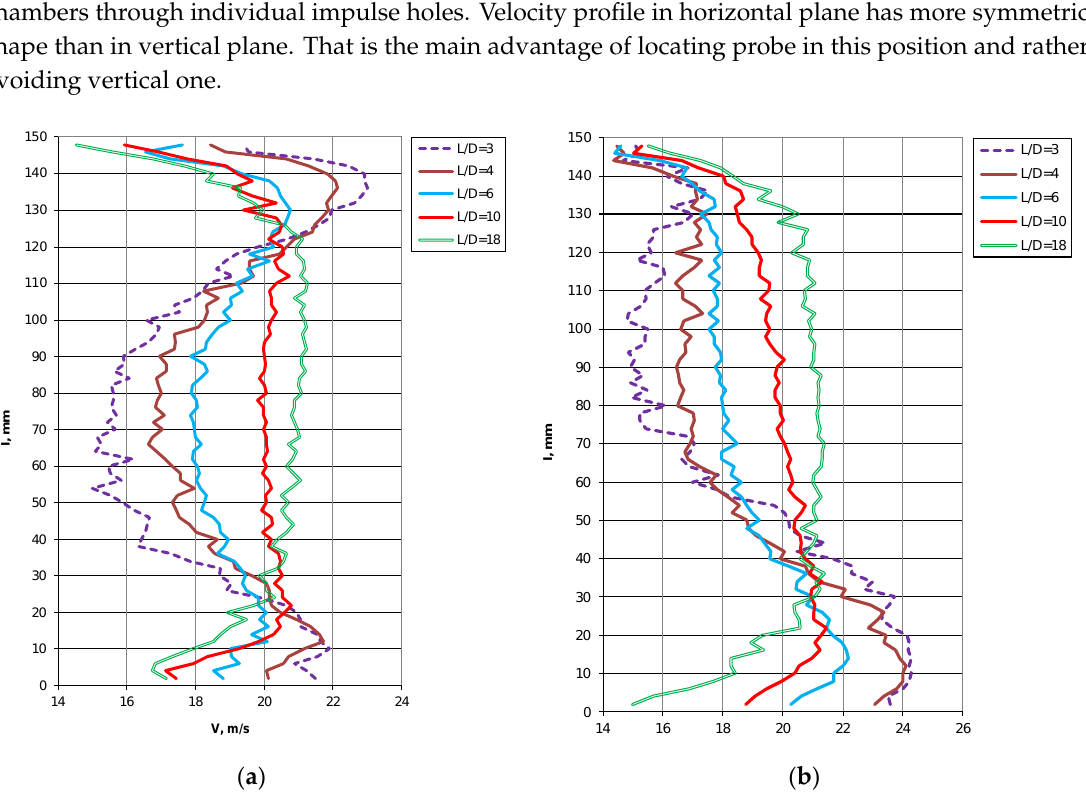
Figure 8. Velocity profile behind an Rc = 1D elbow at mean velocity w = 18 m / s. ( a ) horizontal position, ( b ) vertical position.